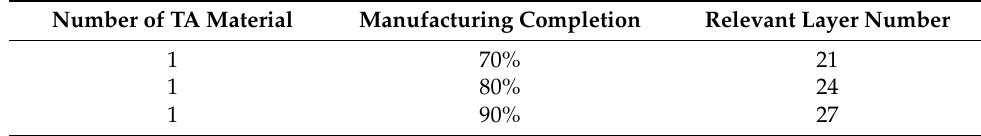
Table 3. Configuration of hardness testing samples.